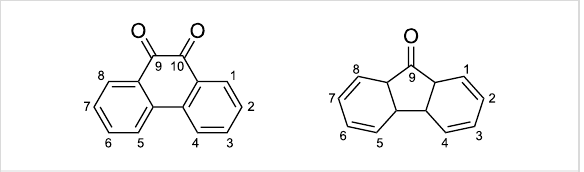
Figure 1: 9,10-phenanthrenequinone (left) and 9-fluorenone (right).